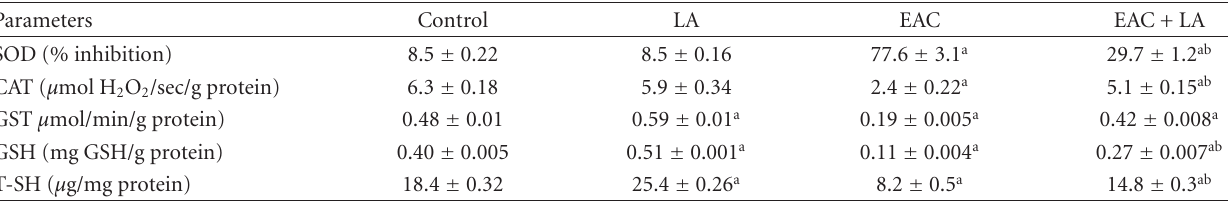
Table 5: Activities of superoxide dismutase (SOD), catalase (CAT), and glutathione-S-transferase (GST) (as well as levels of glutathione, GSH, total thiols (T-SH)) in liver of di ff erent animal groups. Parameters